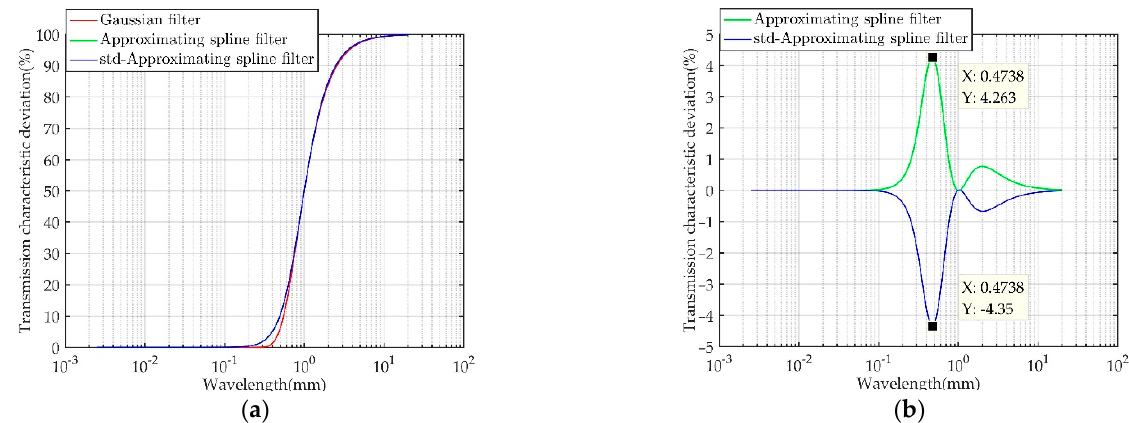
Figure 3. ( a ) Transmission characteristic and ( b ) transmission characteristic deviation of Gaussian Figure 1 and std-approximating spline filter ( β = 0.62524 ) .